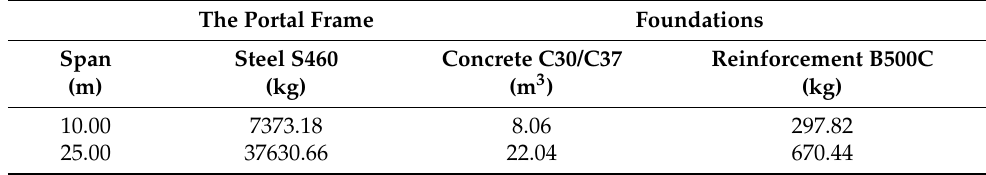
Table 3. Quantities of the steel frames.